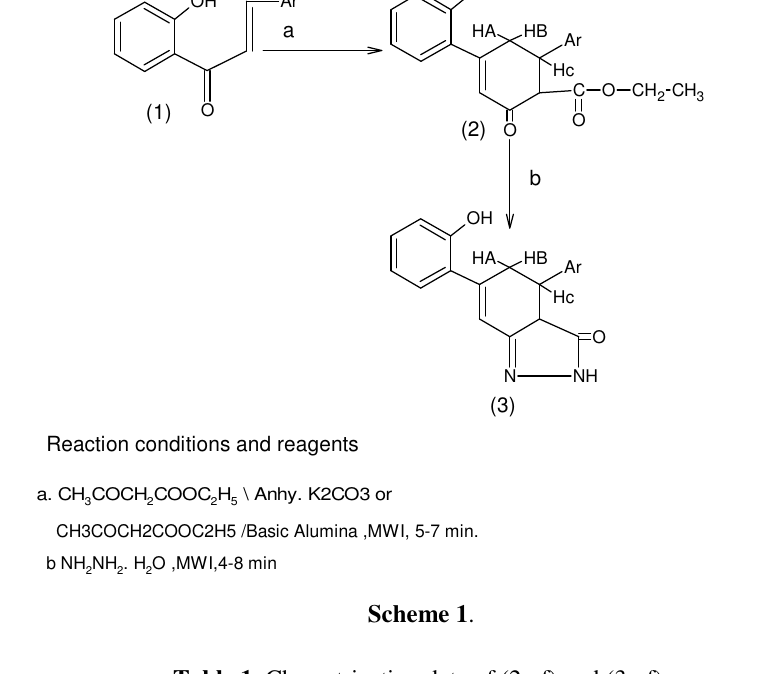
Table 1. Charactrization data of (2a-f) and